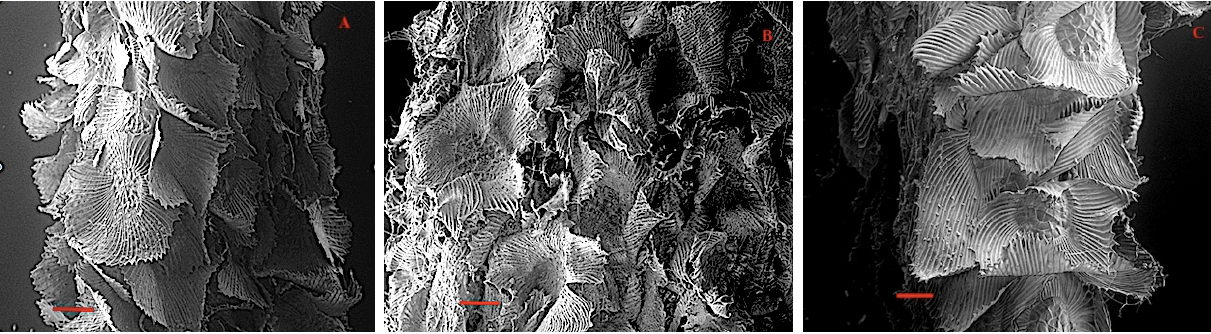
Figure 3. Details of the peltate scale trichomes: ( A ). Tillandia landbeckii , ( B ). T. marconae , ( C ). T. virescens . Bar = 100 µm.